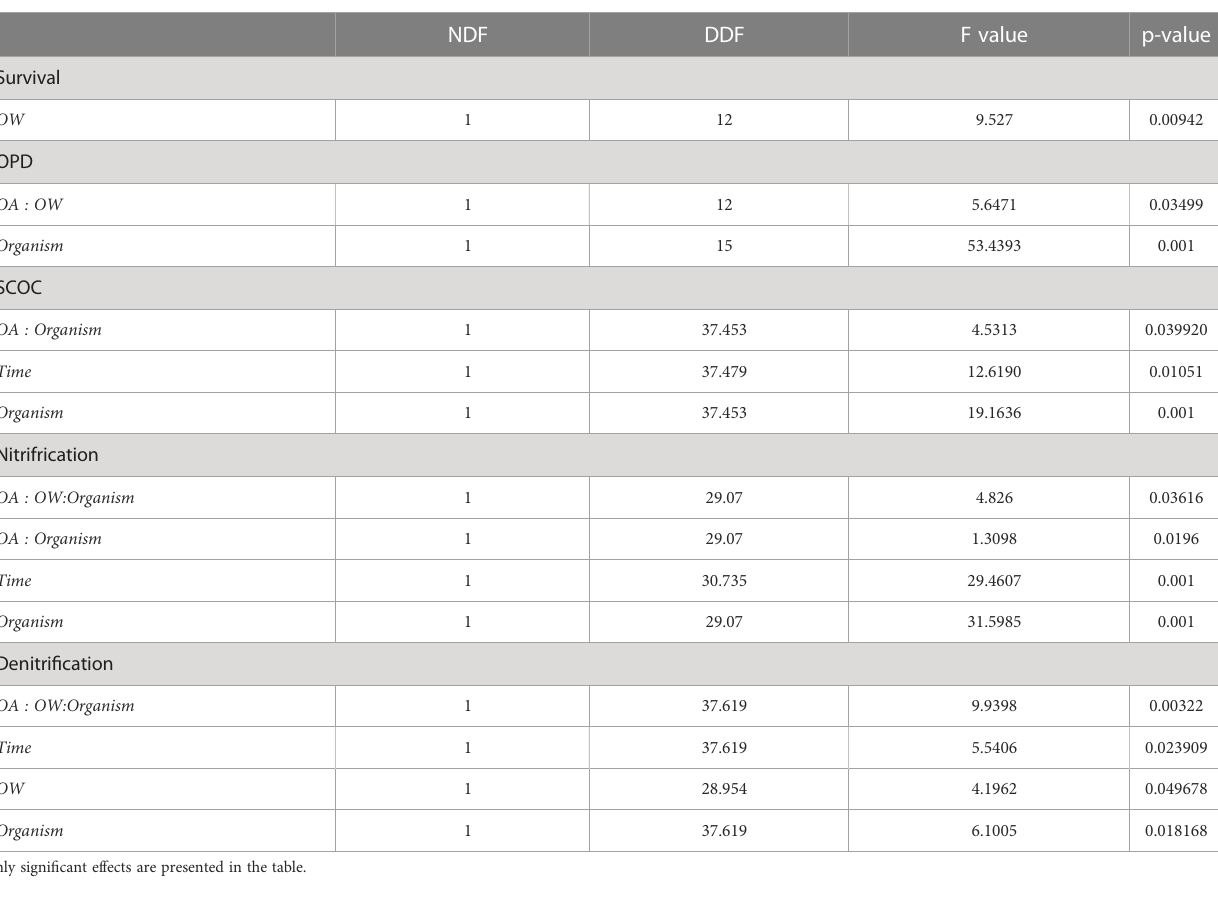
TABLE 2 Linear mixed effects models comparing OPD and biogeochemical cycling in different treatments; seawater temperature, seawater pH , Abra alba presence and experimental